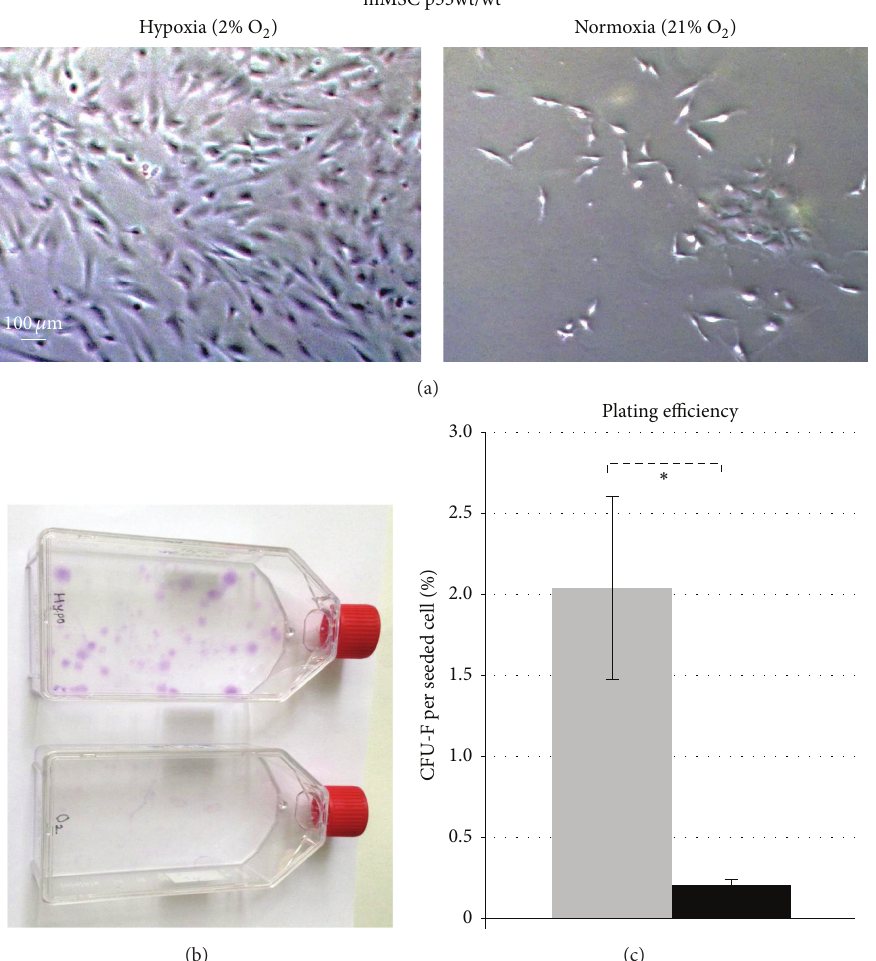
Figure 1: Effects of oxygen levels on long-term in vitro culturing and colony forming capacity of p53 wild-type mMSCs. (a) Proliferation and morphology of mMSCs p53wt/wt cultured in hypoxic conditions (2% O 2 , left) and in normoxic conditions (21% O 2 , right). Representative images show mMSCs cultured for 32 days. (b) Colony forming ability of mMSCs in hypoxic (upper) and normoxic (lower) atmospheres 14 days after plating 5,000 cells in a 75 cm 2 flask. (c) Plating efficiency calculated as mean values of fibroblast colony forming units (CFU-F) per plated cell ± standard error of the mean ( 𝑛 = 4 ) in hypoxic (grey bar) and normoxic (black bar)